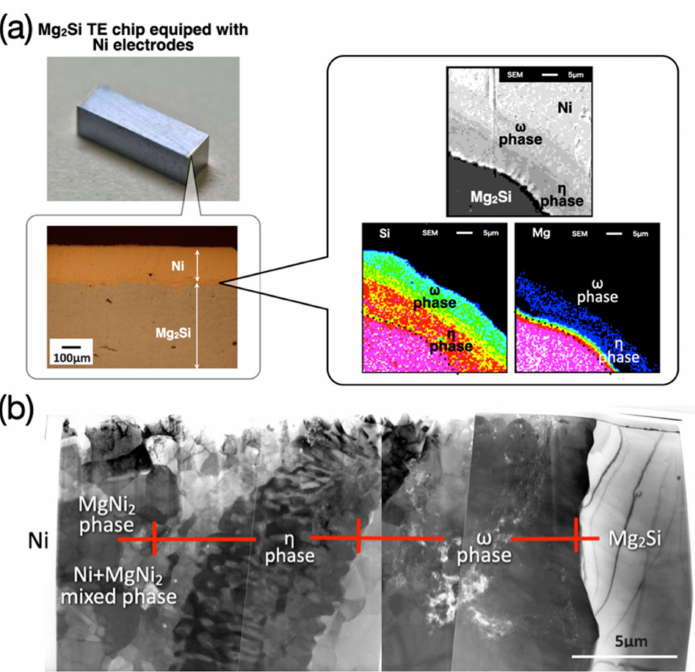
Figure 7. Observations of the interfaces between the Ni electrodes and the Mg 2 Si matrix: ( a ) cross- sectional optical microscope images and SEM-EDX composition analysis for the Ni/Mg 2 Si interface formed by monobloc sintering; ( b ) cross-sectional HR-XTEM images of the sample made by monobloc sintering. The sample was cut from a sintered pellet.